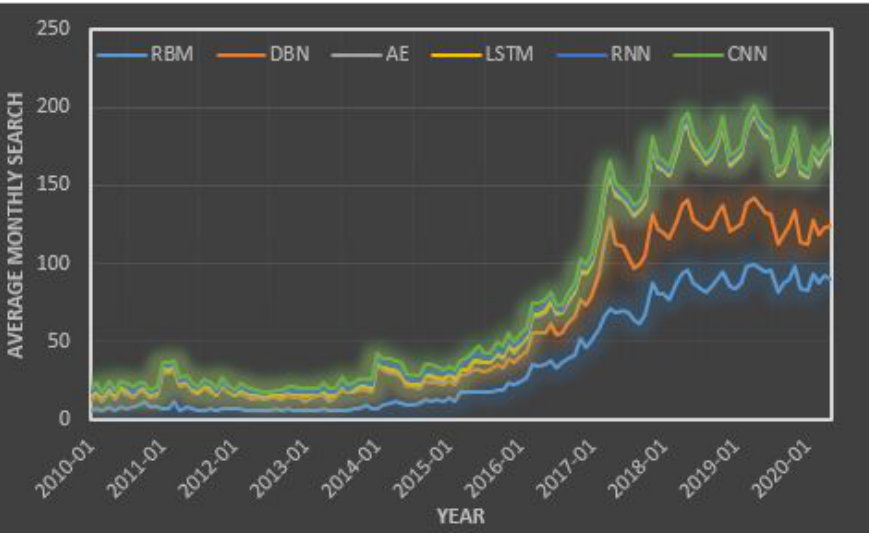
Figure 3. Google trend shows more interest on CNN in recent